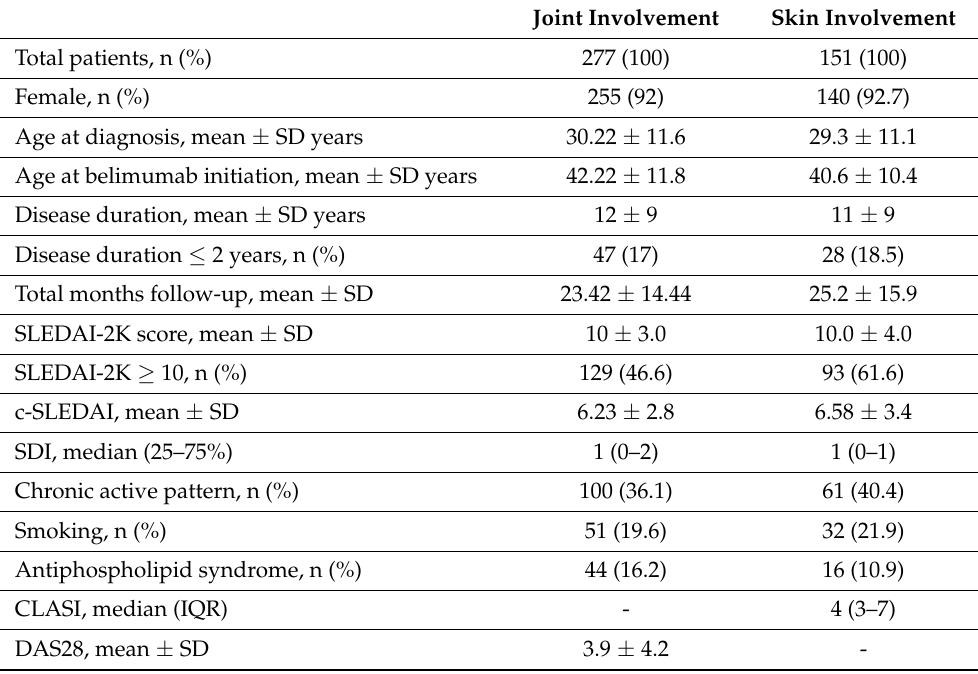
Table 1. Baseline demographic, clinical, and serological variables in SLE patients with joint and skin involvement at baseline treated with